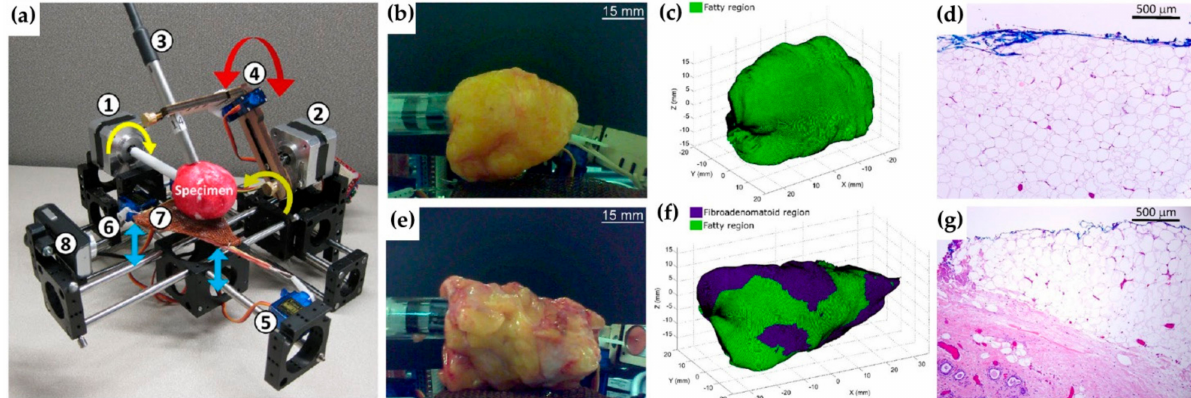
Figure 5. Combined TIR-AF and Raman spectroscopy analysis of a human specimen containing a phyllodes tumour. ( a ) optical image; ( b ) ratiometric TIR-AF image; ( c ) H&E-stained tissue section; ( d ) threshold image (0.8 < T < 2), showing the sampling locations for the Raman acquisition, dotted in yellow; ( e ) average Raman spectra of stroma (blue), tumour (red) and adipose tissue (green) and corresponding standard deviation (shaded in grey) [109].